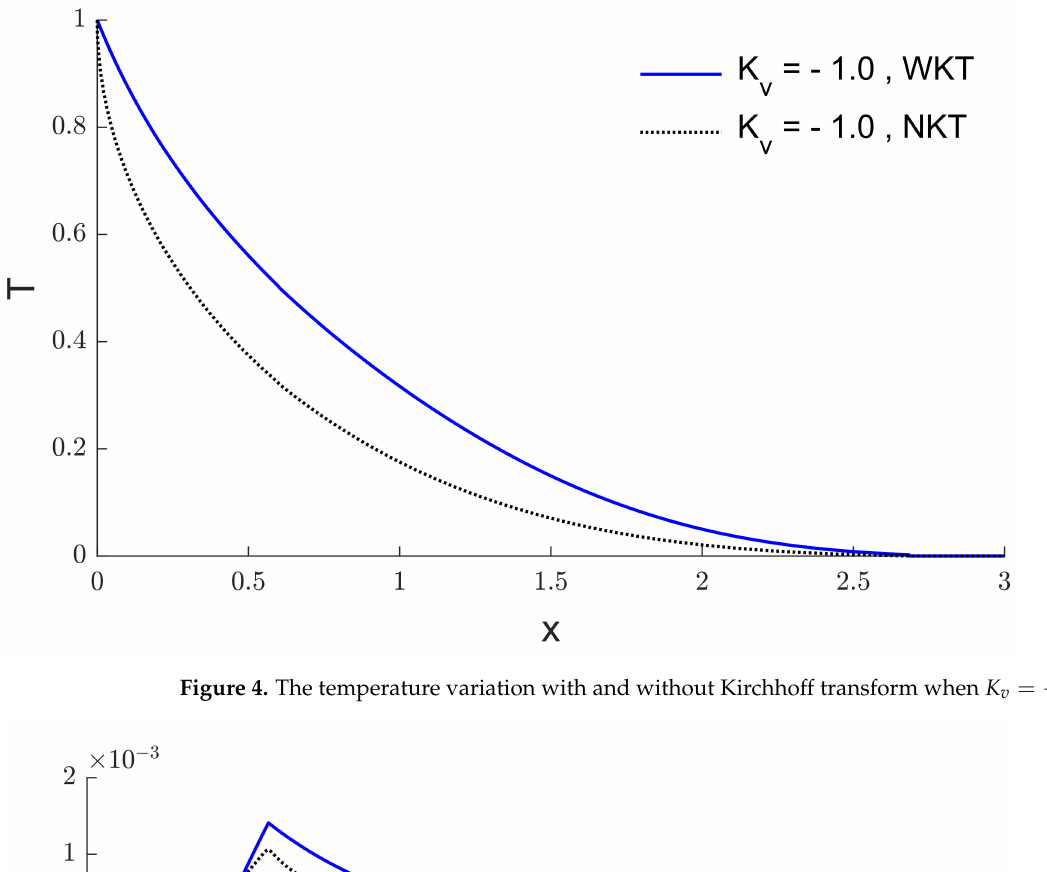
Figure 4. The temperature variation with and without Kirchhoff transform when K v = − 1.